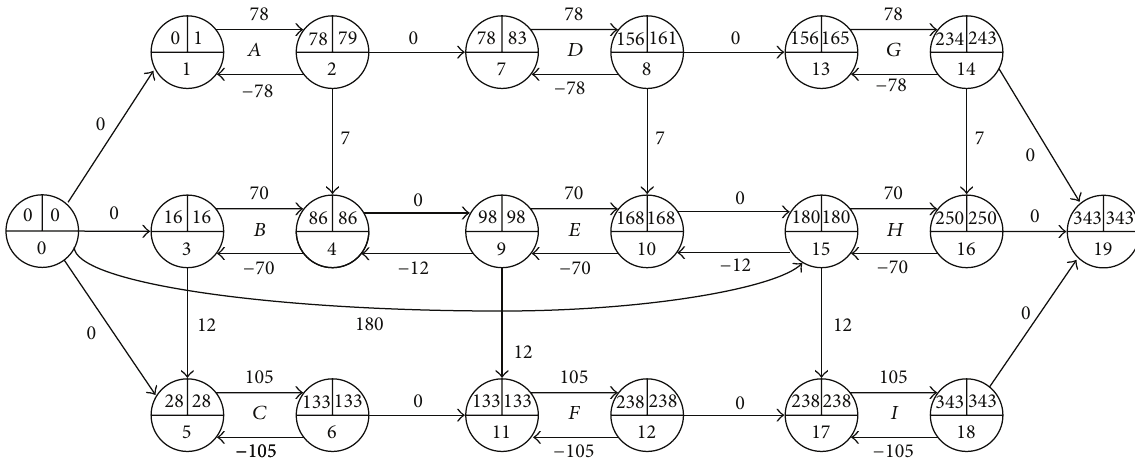
Figure 3: Delaying start time of the activity 𝐻 by 9 in Figure 1.